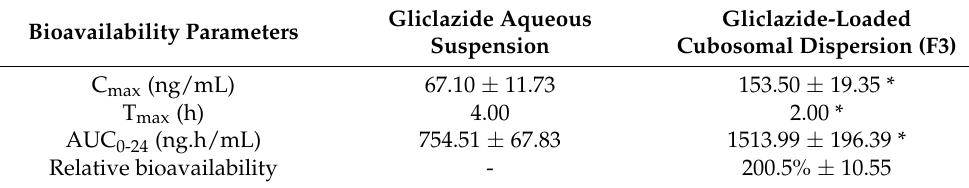
Figure 5. Mean (n = 6 ± SD) gliclazide plasma concentration–time profiles after the administration of a single oral dose (10 mg/kg) of gliclazide-loaded cubosomal nanoparticles and drug suspension to rats. Table 2. Mean values of bioavailability parameters of gliclazide in rats (n = 6 ± SD) after administra- tion of a single oral dose (10 mg/kg) of gliclazide aqueous suspension and equivalent dose of cubosomal nanoparticles (F3).